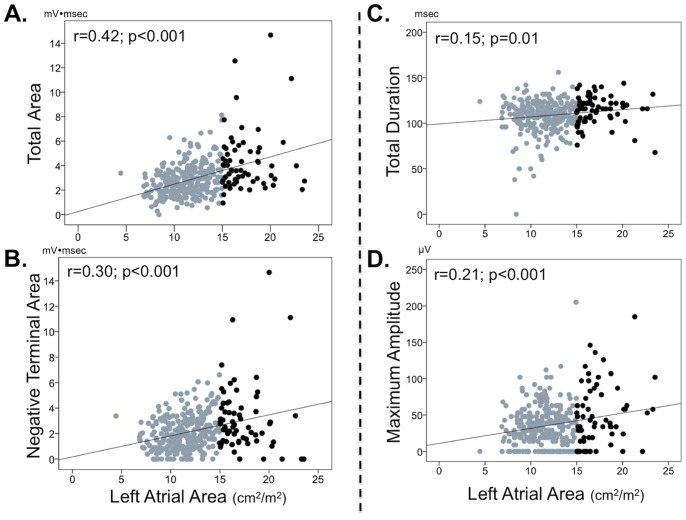
Left Atrial Size.Scatter plots relating CMR-quantified LA size to P wave morphology as measured in ECG lead V1. Data presented for total P wave area (1A), negative terminal area (1B), duration (1C), and maximum amplitude (1D). Patient data stratified based on normal (grey) and dilated (black) left atrial size on cine-CMR using an established diagnostic cutoff (>15 cm2/m2) [19].